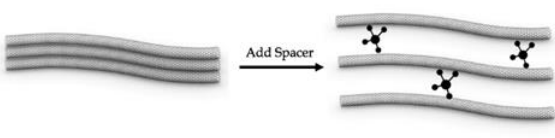
Figure 1. Molecular spacer intercalation between the CNTs.